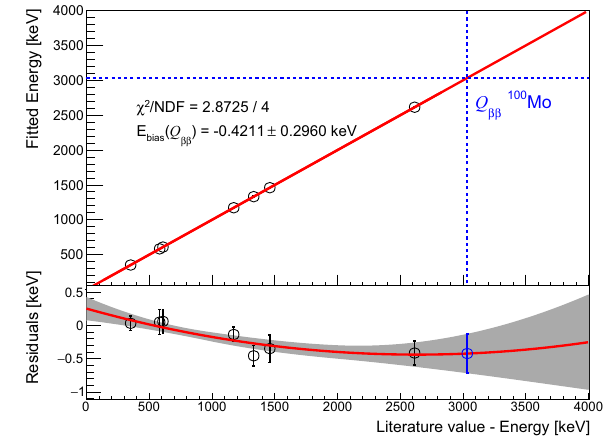
Fig. 11 Resolution scaling fit showing the scaling factor R , between backgroundandcalibrationdataforeachpeakinphysicsdata.Wemodel (cid:10) + p p 2 this as R ( E ) = 1 E and extrapolate to Q ββ to obtain a global 0 scale factor. The choice of functional form derives from the energy resolution scaling in data following this same functional form